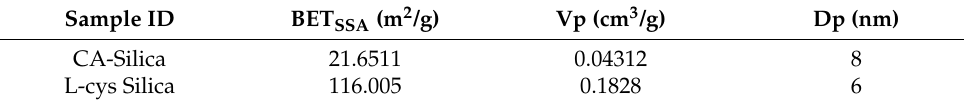
Table 2. Textural properties of SCBA nano CA-Silica and L-cys Silica. Sample ID BET SSA (m 2 /g) Vp (cm 3 /g) Dp (nm) CA-Silica 21.6511 0.04312 8 L-cys Silica 116.005 0.1828 6